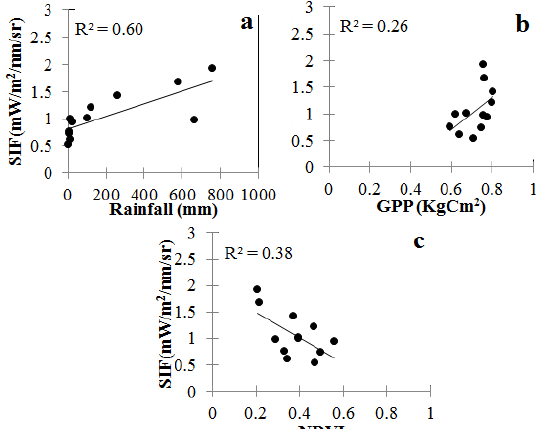
Figure 7. GOME-2 SIF relationship with rainfall (a), GPP (b) and NDVI (c) for